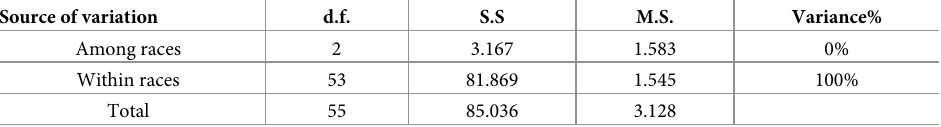
Table 7. Analysis of molecular variance for three Fusarium oxysporum f. sp. niveum races collected from four dif- ferent locations in the southeastern United States. Source of variation